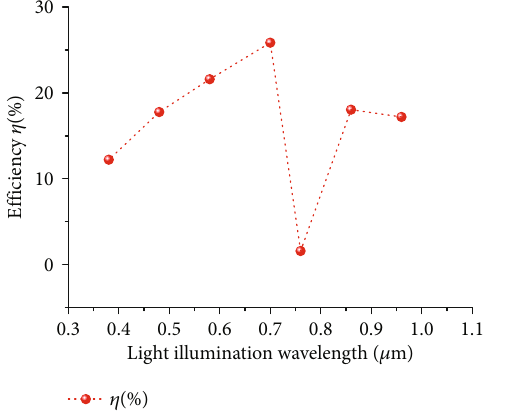
Figure 15: Conversion e ffi ciency illumination wavelength.